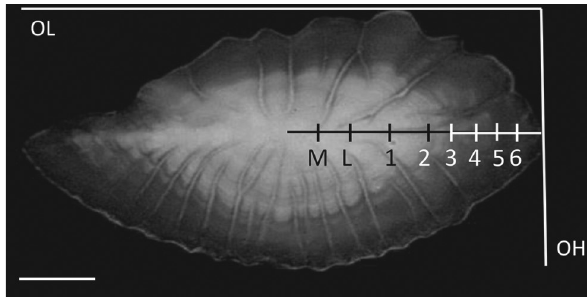
Figure 3. Trachurus lathami : external surface of a left otolith showing measurements (OL = otolith length and OH = otolith height) and ring analysis (M and L are rings formed before the first annual one; more details in the text). Scale bar: 1